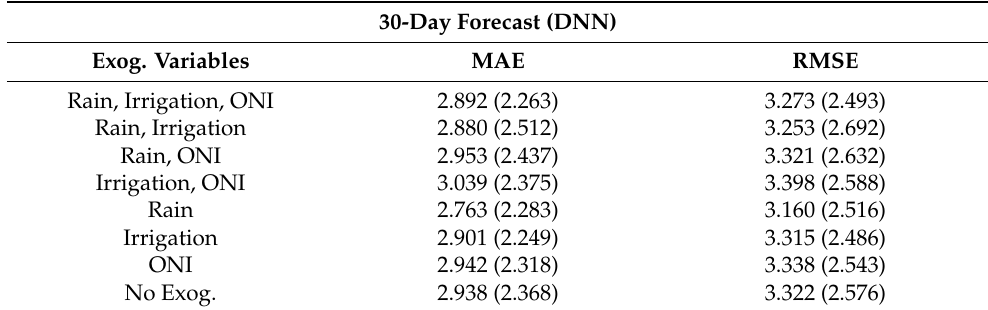
Table 11. Average estimates for MAE and RMSE, and their standard deviations calculated using TSCV for a 30-day forecast across different combinations of exogenous